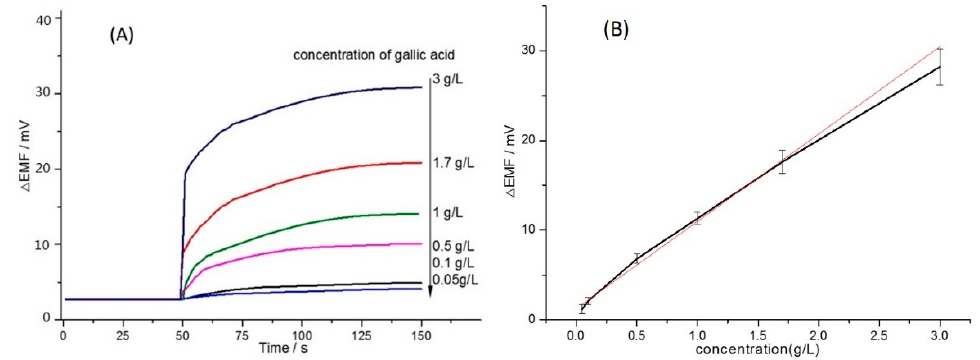
Figure 5. ( A ) Potential responses of gallic acid solutions. ( B ) Positive linear correlation between the proportion of gallic acid and potential response values .